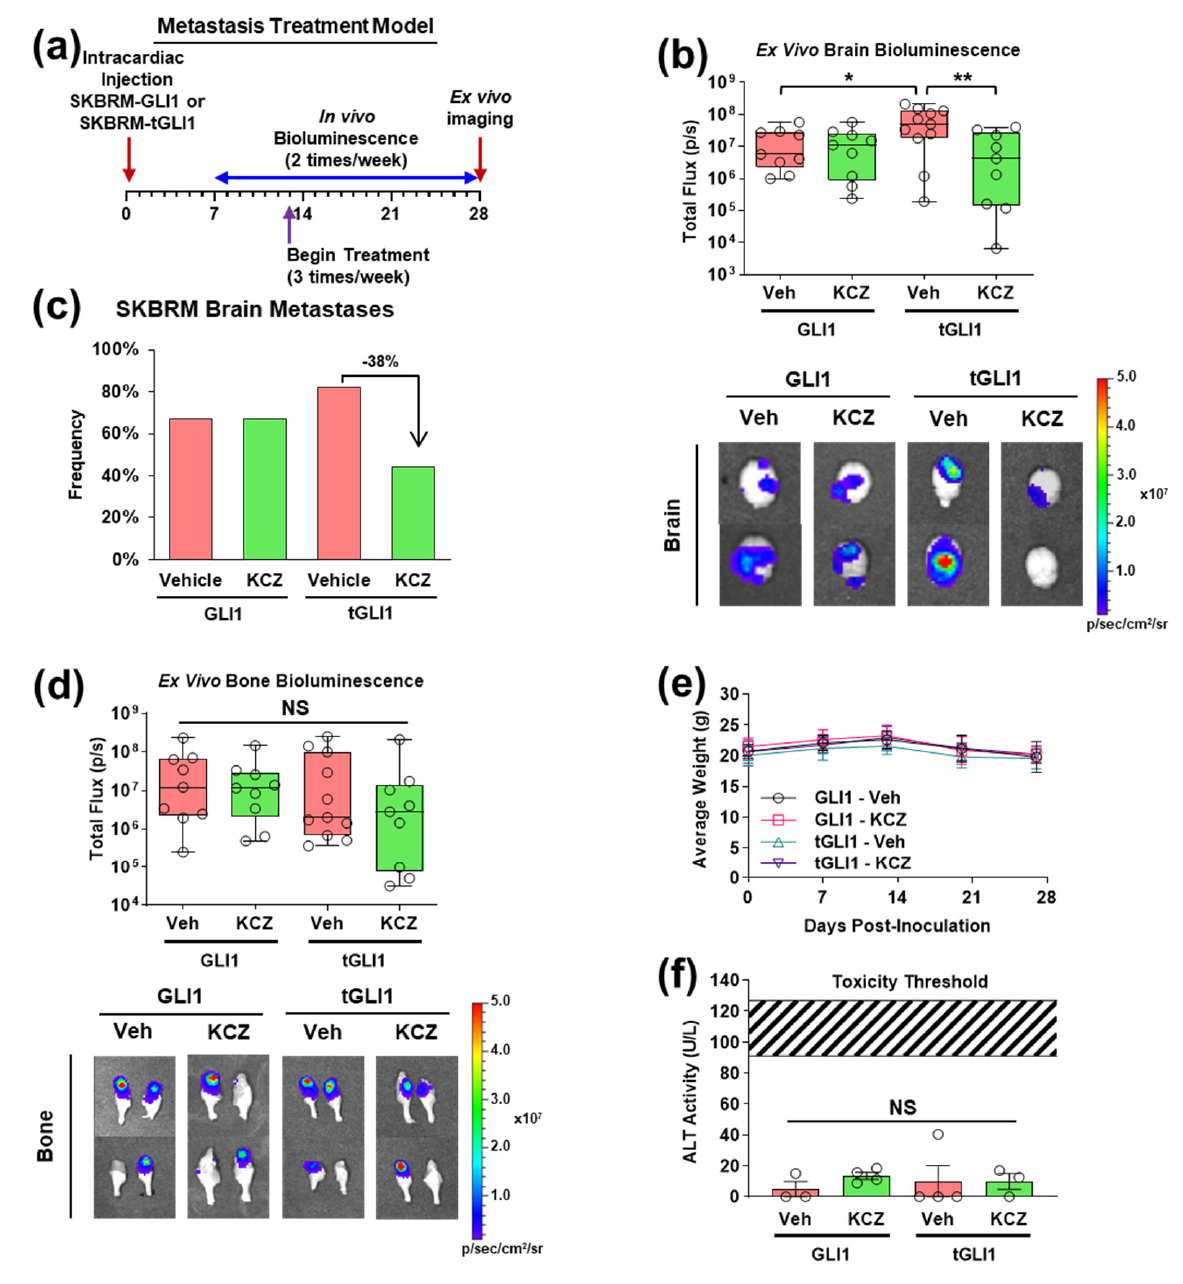
Figure 4. KCZ selectively reduces the progression of tGLI1-positive breast cancer brain metastases in vivo. ( a ) Schema for intracardiac brain metastasis treatment model. Isogenic luciferase-expressing GLI1 or tGLI1 SKBRM cells were injected into the left ventricle of female nude mice and tumor